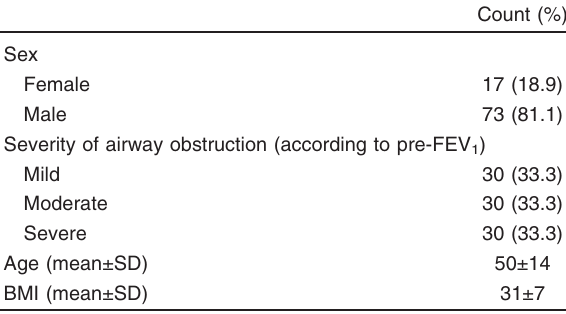
Table 1 Descriptive characteristics of the patients in the study